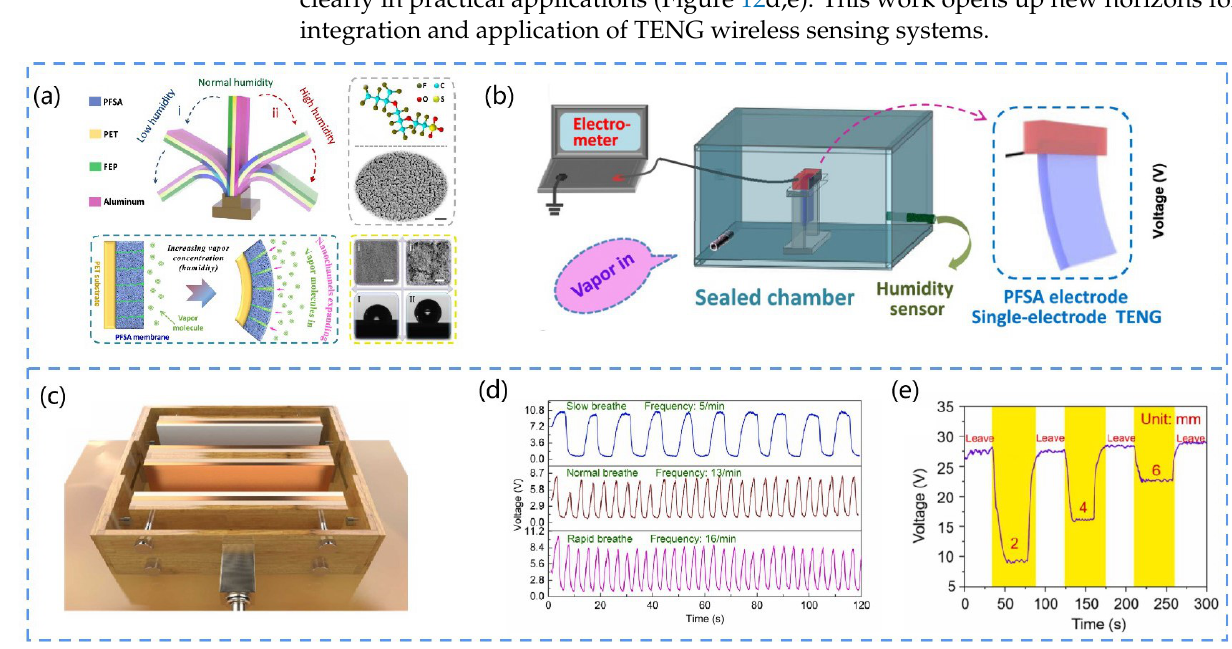
Figure 12. ( a ) Schematic diagram of the TENG-based humidity sensing system. ( b ) Schematic diagram of the operation of the TENG sensing system under steam drive. Reprinted from [88] with permission from ACS Publications. ( c ) Schematic diagram of the dual-TENG. ( d ) Real-time monitoring of breathing conditions by the sensor. ( e ) Signal of the sensor on finger movement. Reprinted from [89] with permission from Elsevier.